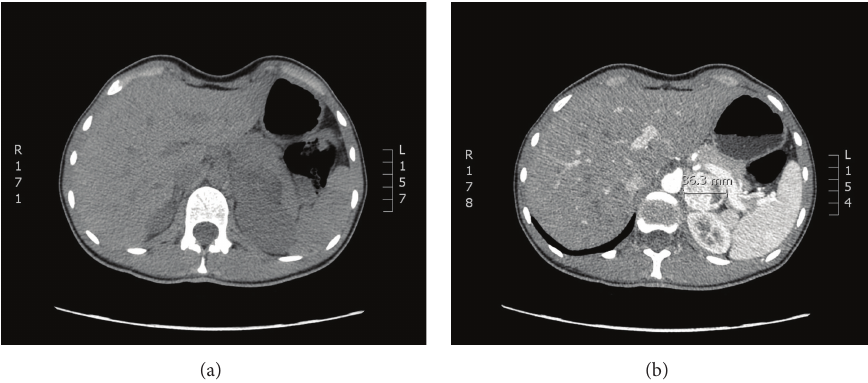
Figure 2: CT scan of the abdomen showing a mass in the left adrenal gland in the noncontrast and contrast